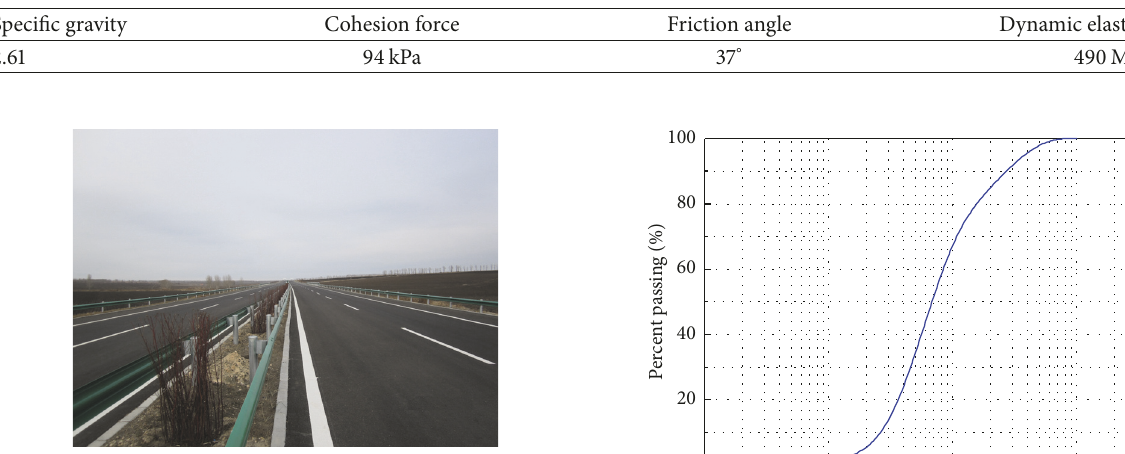
Table 1: Geomechanical parameters of soil.